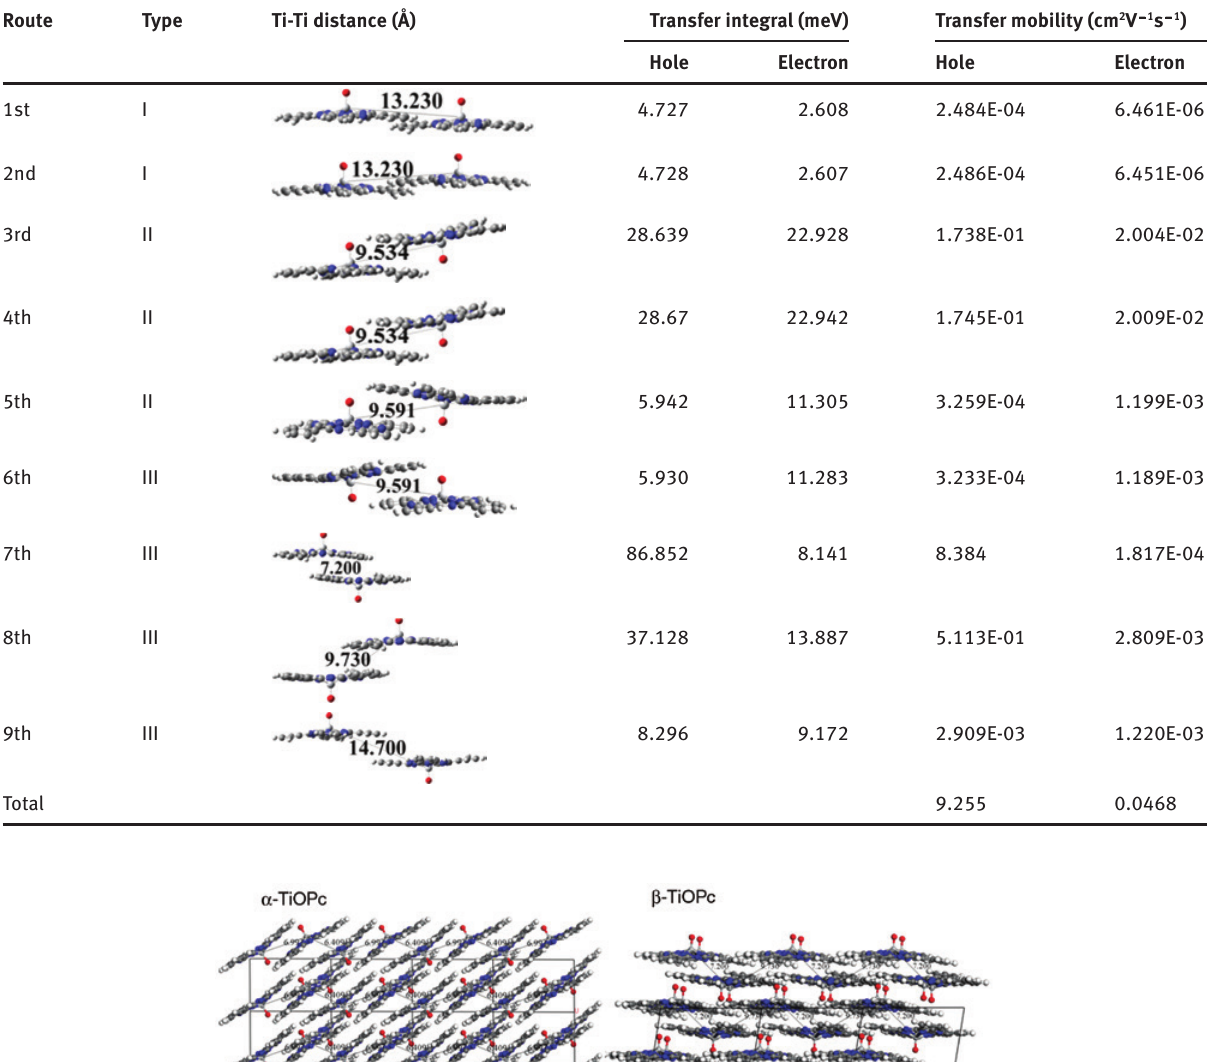
Table 3: The main molecular pairs and corresponding calculated charge transfer integrals and charge transfer mobilities in the β -TiOPc crystals.